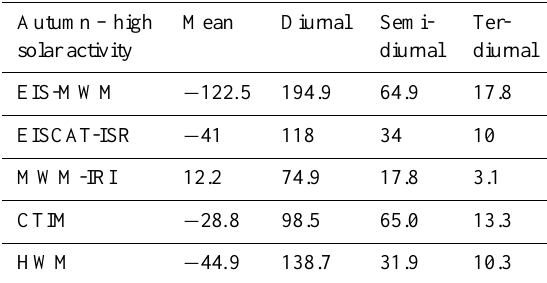
Table 8. As for Table 1 but for winter season, high solar